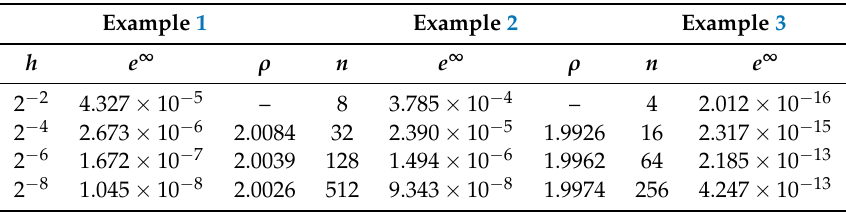
Table 2. Numerical results in Examples